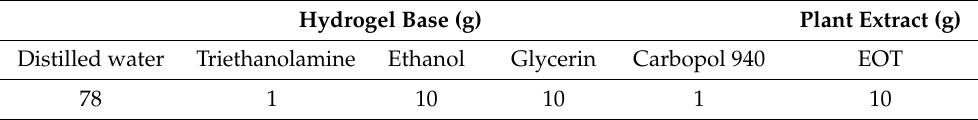
Table 1. The composition of the hydrogel. Hydrogel Base (g) Plant Extract (g) Distilled water Triethanolamine Ethanol Glycerin Carbopol 940 EOT 78 1 10 10 1